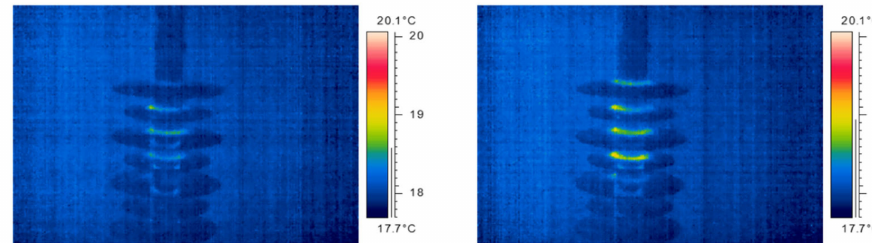
Figure 17. Dry-bands onset for heavy pollution.